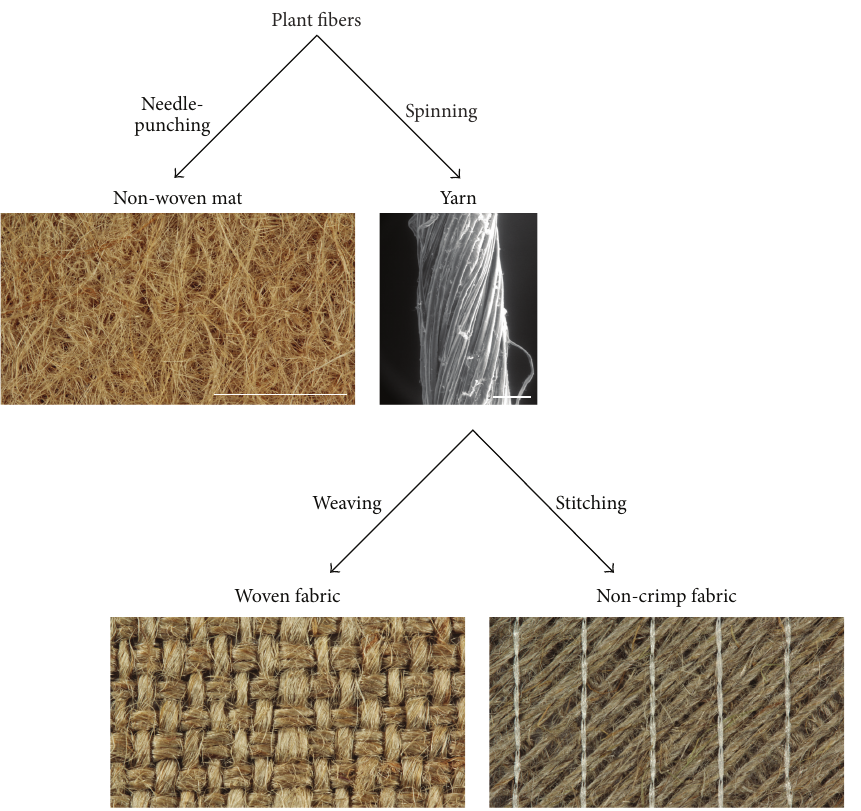
Figure 3: Plant fiber preforms. Scale bar is 10mm for the mat and fabrics, and 0.1 mm for the